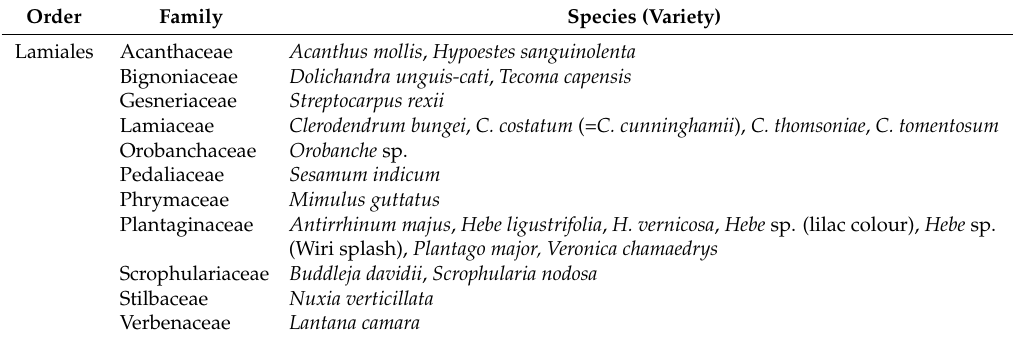
Table 2. Epiplema albida test plants of the Lamiales other than Oleaceae (a further 44 species from 27 families of other orders, mainly plants of economic importance were included and are listed in Appendix A).